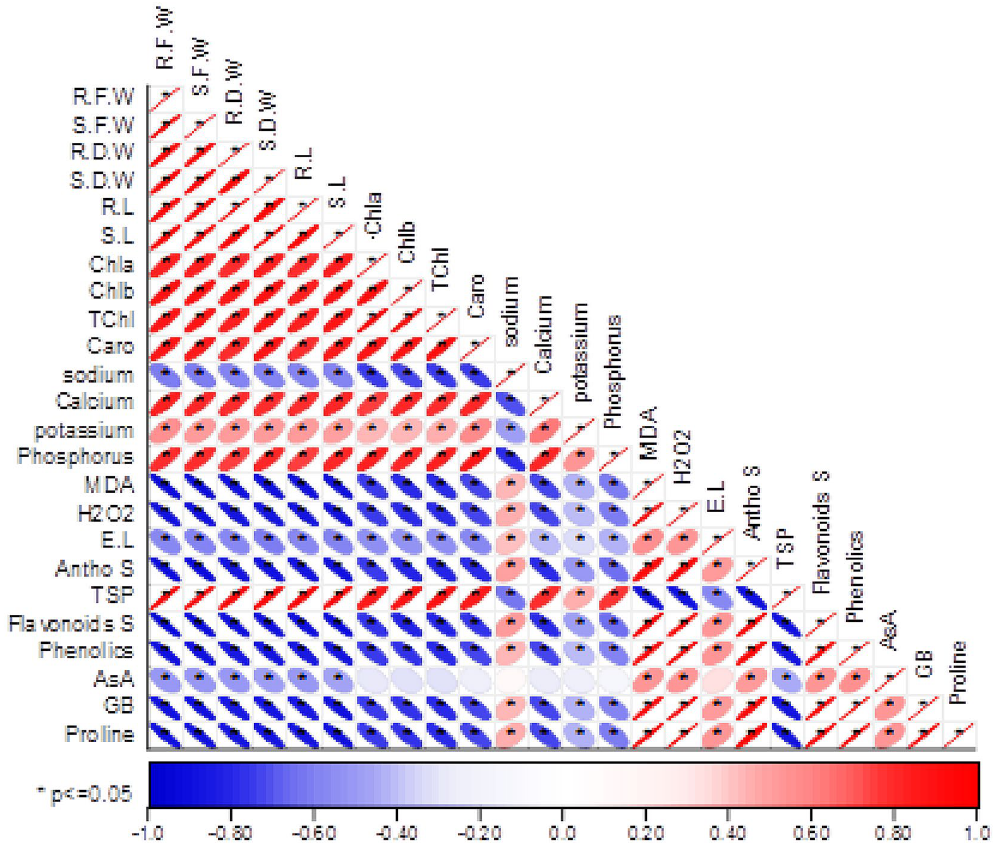
Figure 3. Role of sole and combined application of BR and BC on photosynthetic pigments contents of wheat under 35 WHC and 75 WHC. Bars show means of three replicates. Different error bars represent SE. Different letters indicate significant difference at p ≤ 0.05; LSD Test (75 WHC well-watered, 35 WHC drought stress, C control, BR1 1 μmol foliar applied 24-epibrassinolide, BR2 3 μmol foliar applied 24-epibrassinolide, BC timber waste